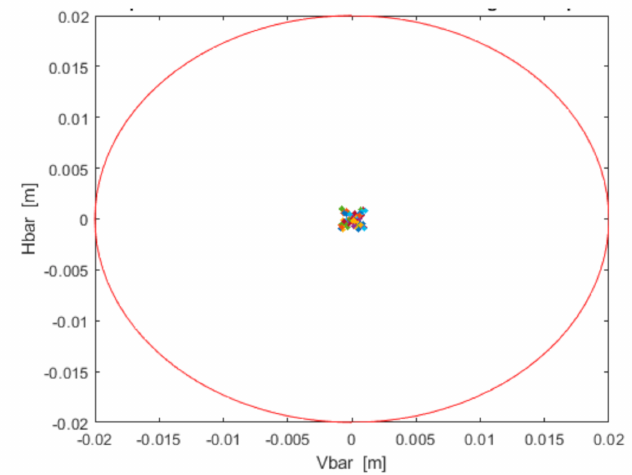
Figure 10. Accuracy at the mating